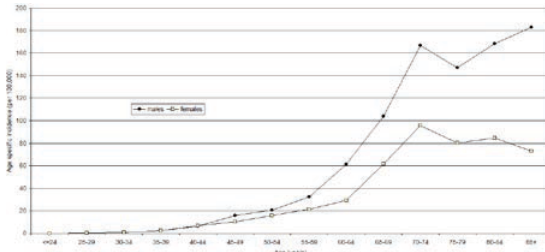
Figure 5. Age-specific incidence (per 100,000) of rectal cancers diagnosed between 1984 and 2003 in Lower